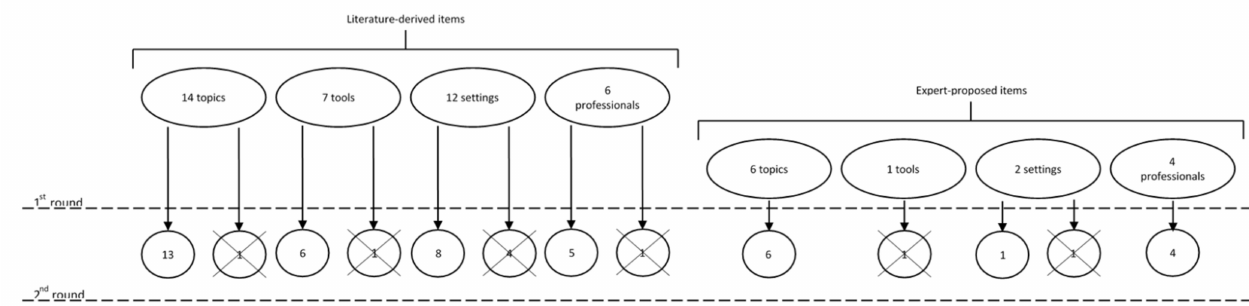
Figure 2. Flowchart of the results of the Delphi process.